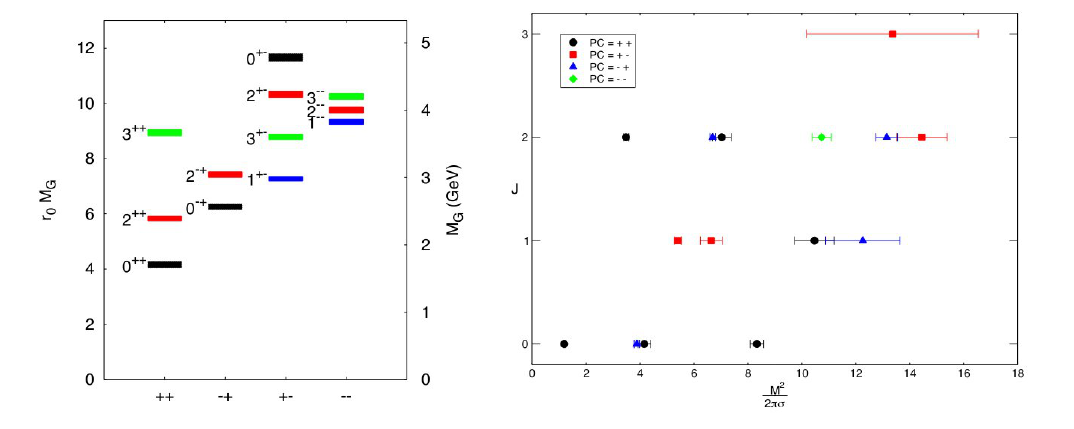
Figure 10: Spectrum of glueballs for pure SU(3) [ 67 ] (left) as a function of J PC quantum numbers and for large N [ 68 ] showing J versus m 2 (right). The parameters ∼ 1 / Λ (cid:48) and σ ∼ Λ (cid:48) 2 . Figure from Ref. [ 69 ] r 0